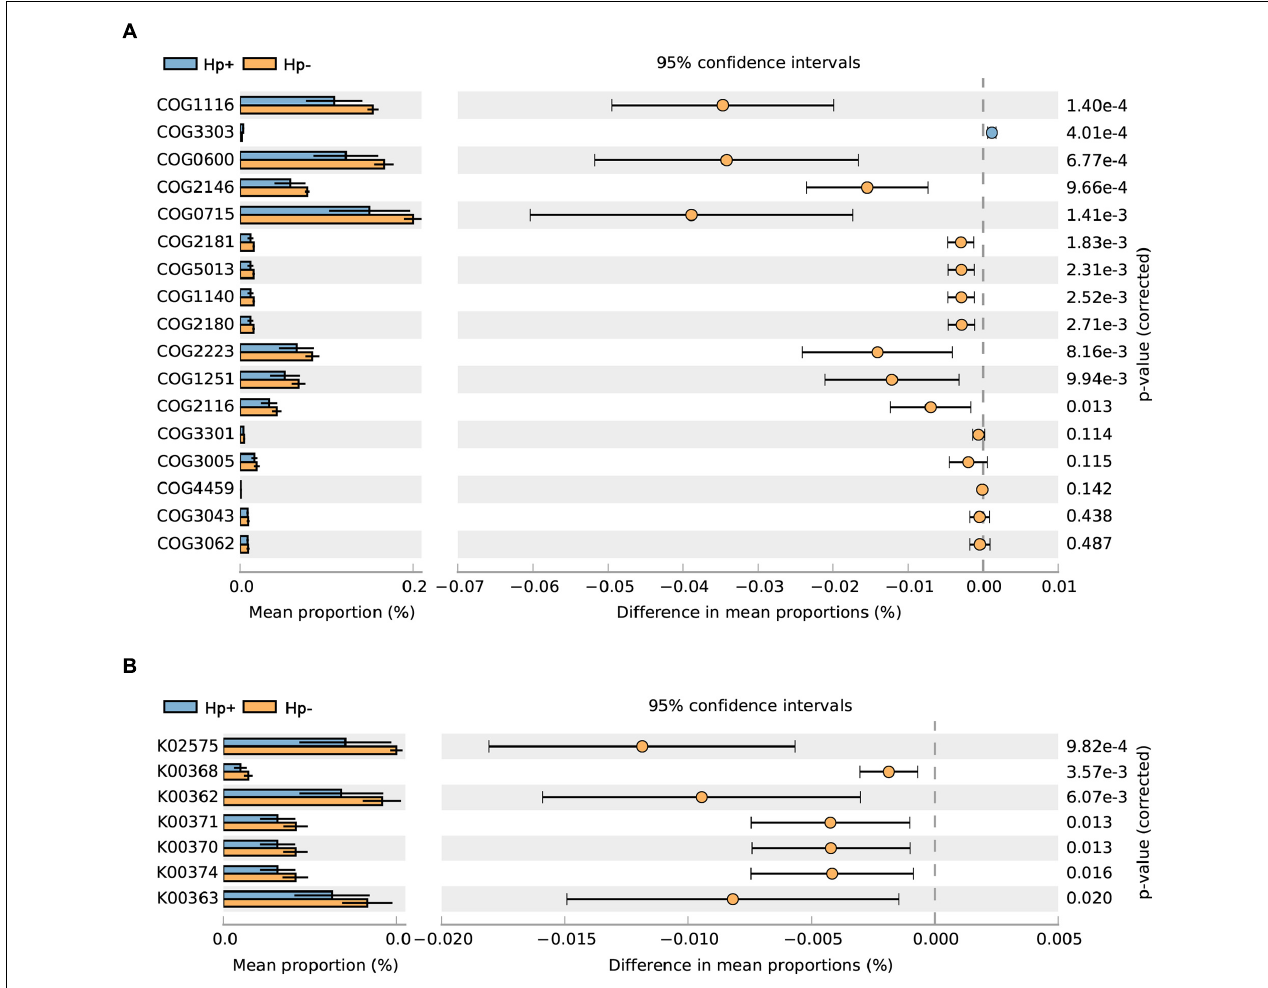
FIGURE 7 | The H. pylori- negative group microbiota is characterized by nitrosating bacteria. Functional classification of the predicted metagenome content of the microbiota of H. pylori- positive group and H. pylori- negative group using (A) COG and (B) KO. The normalized relative frequency of nitrate reductase and nitrite reductase in patients with H. pylori- positive group and H. pylori- negative group are shown. Significance was considered for adjusted P < 0.05. COG, Clusters of Orthologous Groups; KO, Kyoto Encyclopedia of Genes and Genome orthology; Hp+, H. pylori positive group; Hp-, H. pylori negative